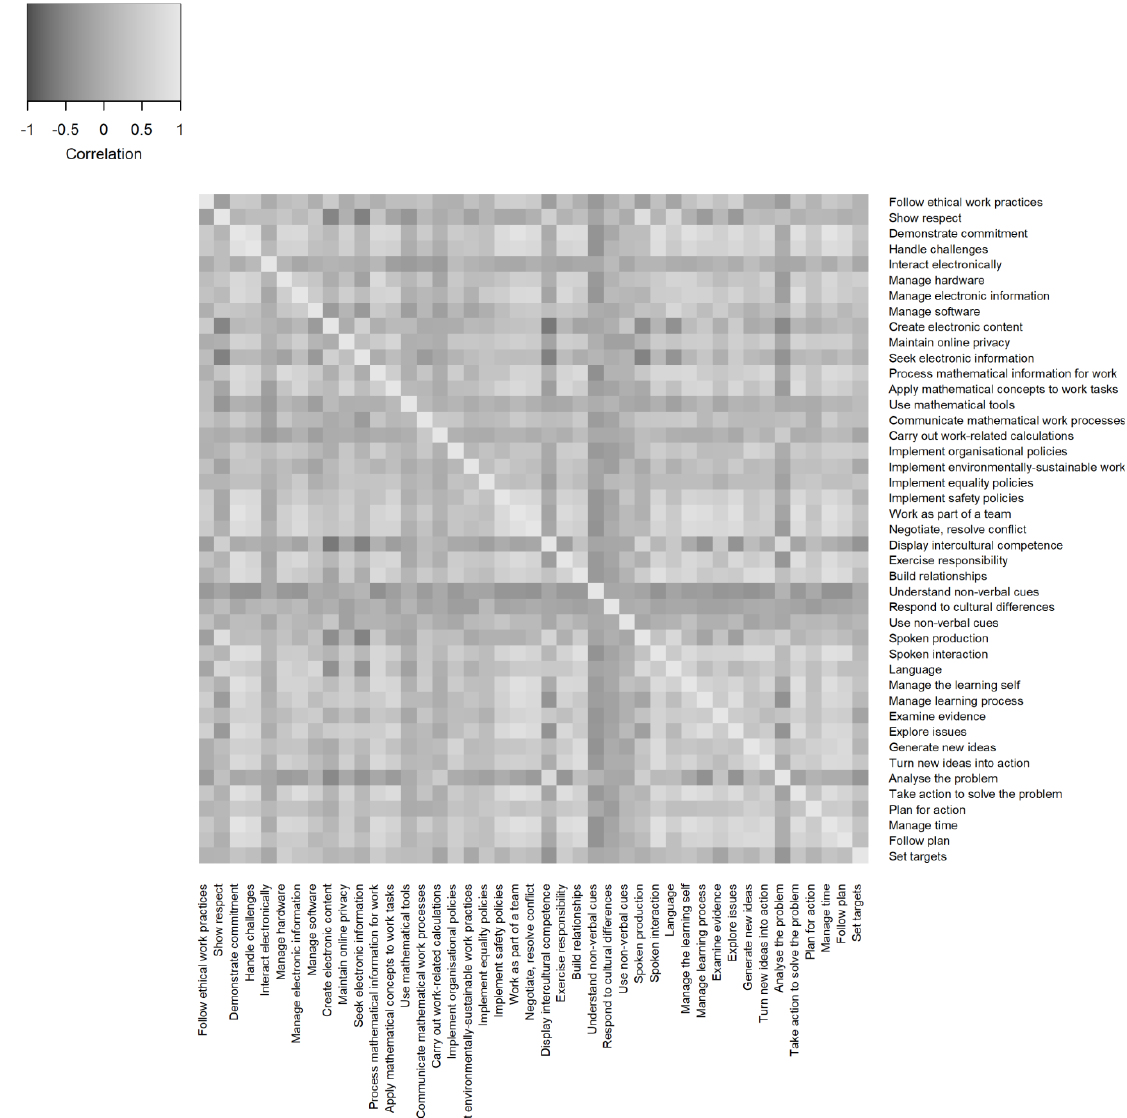
Figure 5 : Correlation coefficients representing the co-occurrence of classes of competences, estimated based on monthly numbers of their occurrences in job